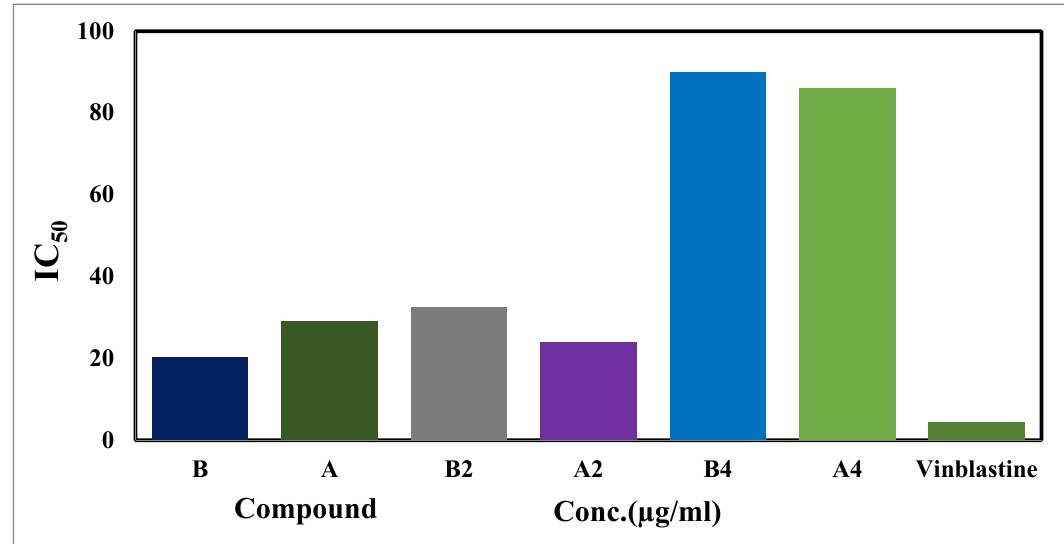
Figure 7. Graph showing the comparative ( A ) antibacterial activity of the ligand (A, B) and its complexes of Pb(II) (A 1 , B 1 ), Mn(II), (A 2 , B 2 ), Hg(II) (A 3 , B 3 ), and Zn(II) (A 4 , B 4 ) against gentamycin and ampicillin as the reference drugs; ( B ) antifungal bioassay of the same ligand and complexes against nystatin before (B, B 1 , B 2 , B 3 , and B 4 ) and after irradiation (A, A 1 , A 2 , A 3 , and A 4 ) at a concentration of 10 mg mL − 1 as the reference drug.